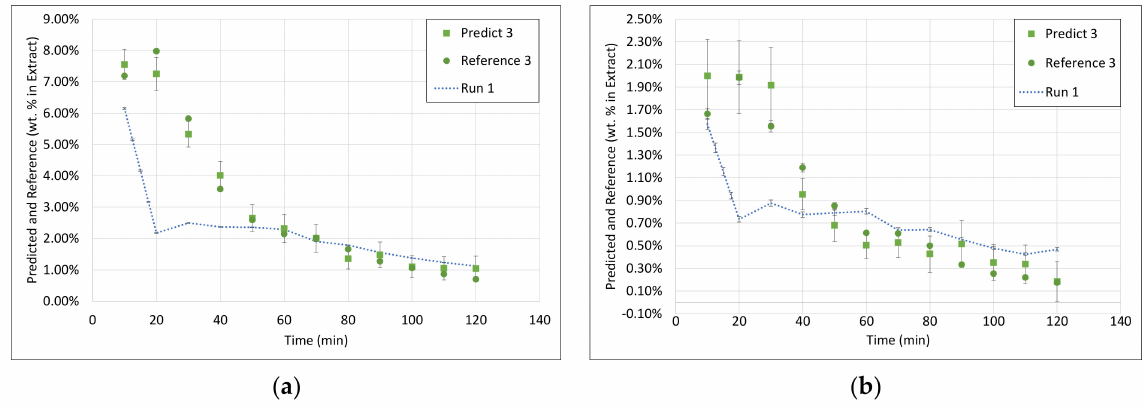
Figure 12. Extraction profiles with reference offline analytics and predicted with FTIR-PLS prediction for ( a ) dry residue and ( b )